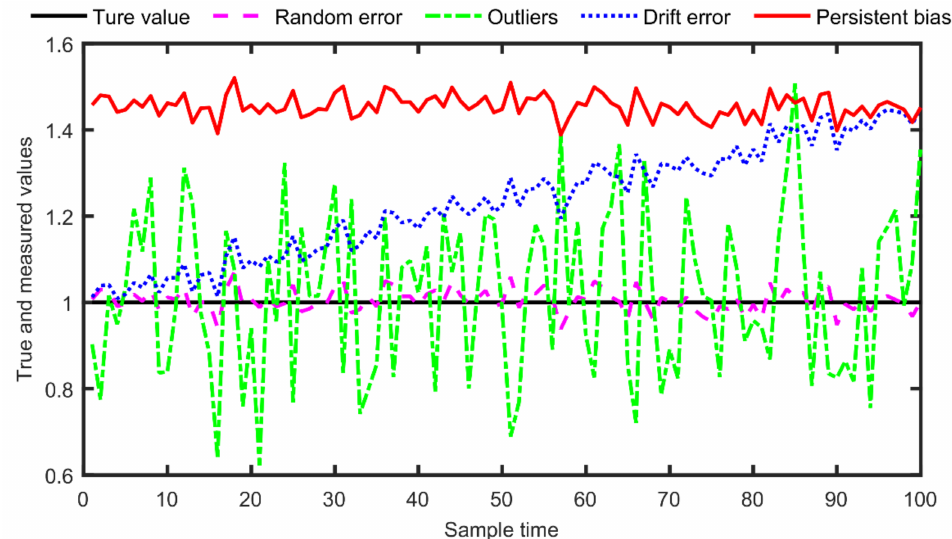
Figure 1. Illustration of different types of gross